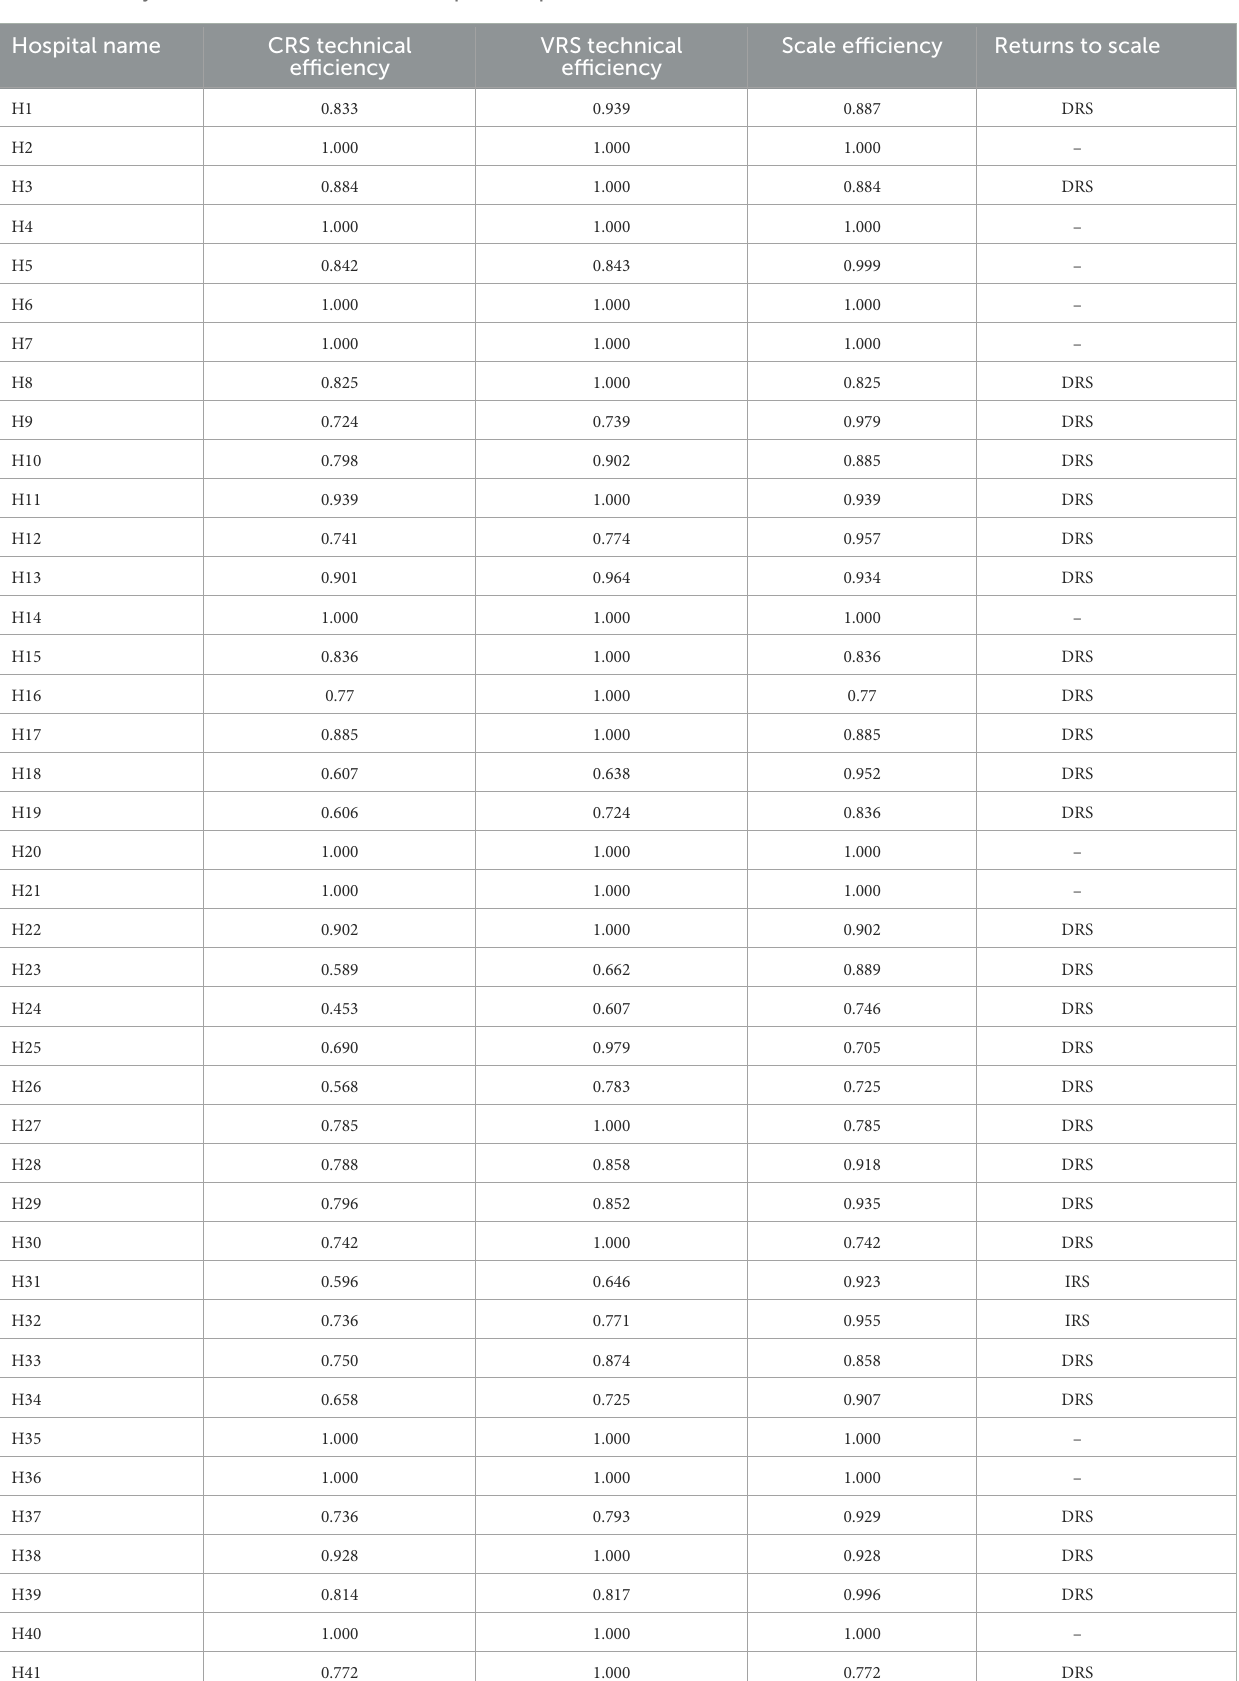
TABLE 5 Efficiency scores and scale reward status of 49 public